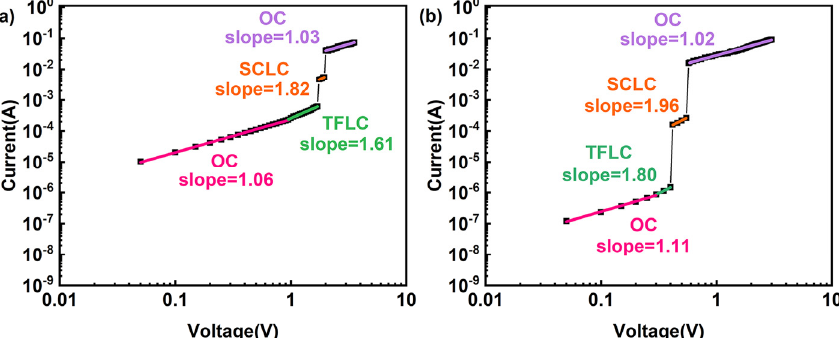
Figure 9. Linear fitting of part log (current) vs. log (voltage) curves: ( a ) ITO/PF-BBO/Al (device A); ( b ) ITO/PF-BBO/Au/Al (device E). ( b ) ITO/PF-BBO/Au/Al (device